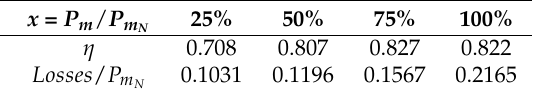
Table 2. Manufacturer Data and normalized losses.